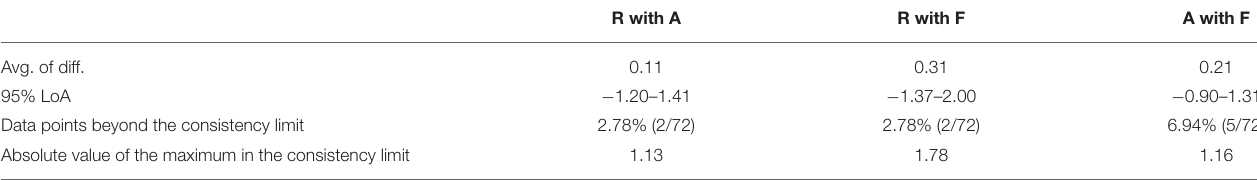
R with A R with F A with F